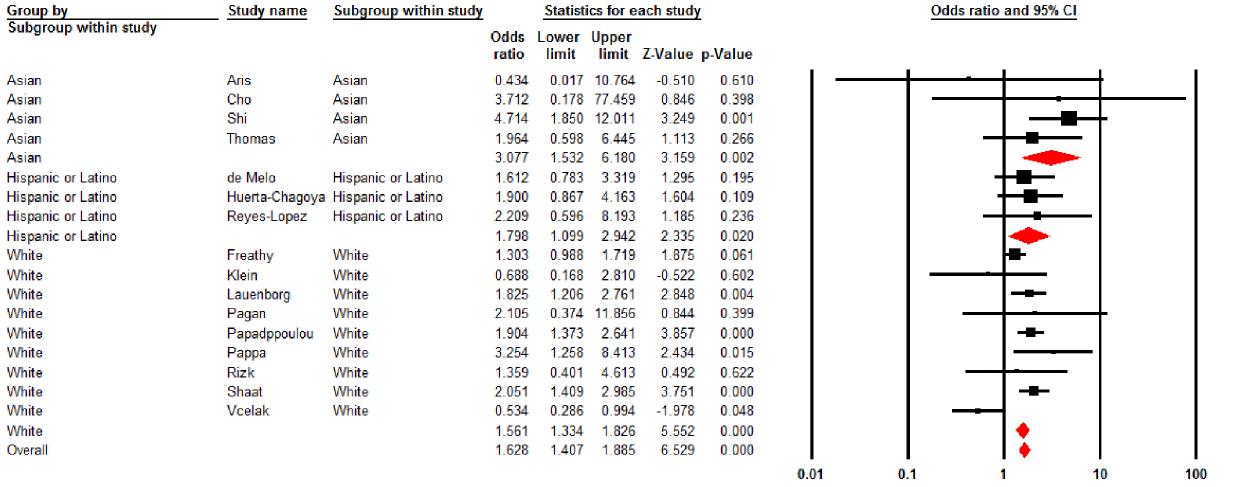
10 – 06). In addition, the TCF7L2 risk haplotype was also associated with metabolic quantitative traits, including higher levels of fasting glycemia (p = 0.0128), and 60 and 120 minutes of OGTT glycemia (p = 2.82 x 10 – 05, p = 0.00028, respectively). In our meta-analysis, we have included one study from Brazil [31] and two studies from Mexico [29, 32] in the Hispanic/ Latino subgroup. The association between the risk T allele of rs7903146 and GDM appears to differences and GDM among Hispanic/Latino subgroups require further investigation.